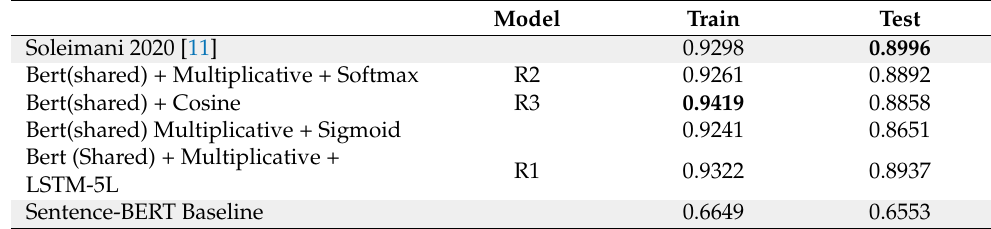
Table 1. Accuracy of the best configurations. Relevance evaluation task.